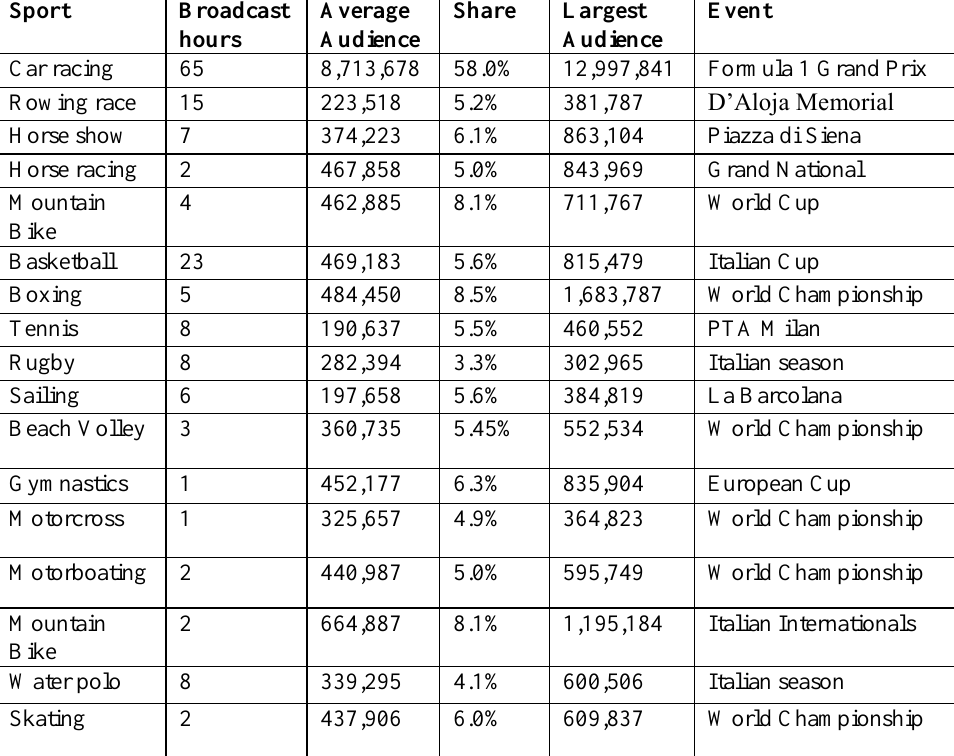
Figure 14: TV Audiences for Other Sports